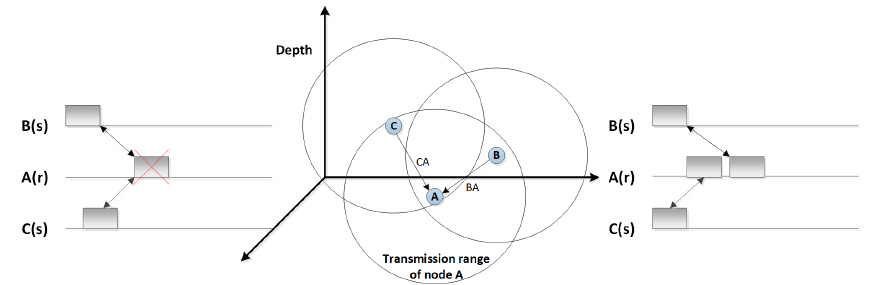
Figure 4. How long propagation delay highly affect the underwater MAC protocol designs.